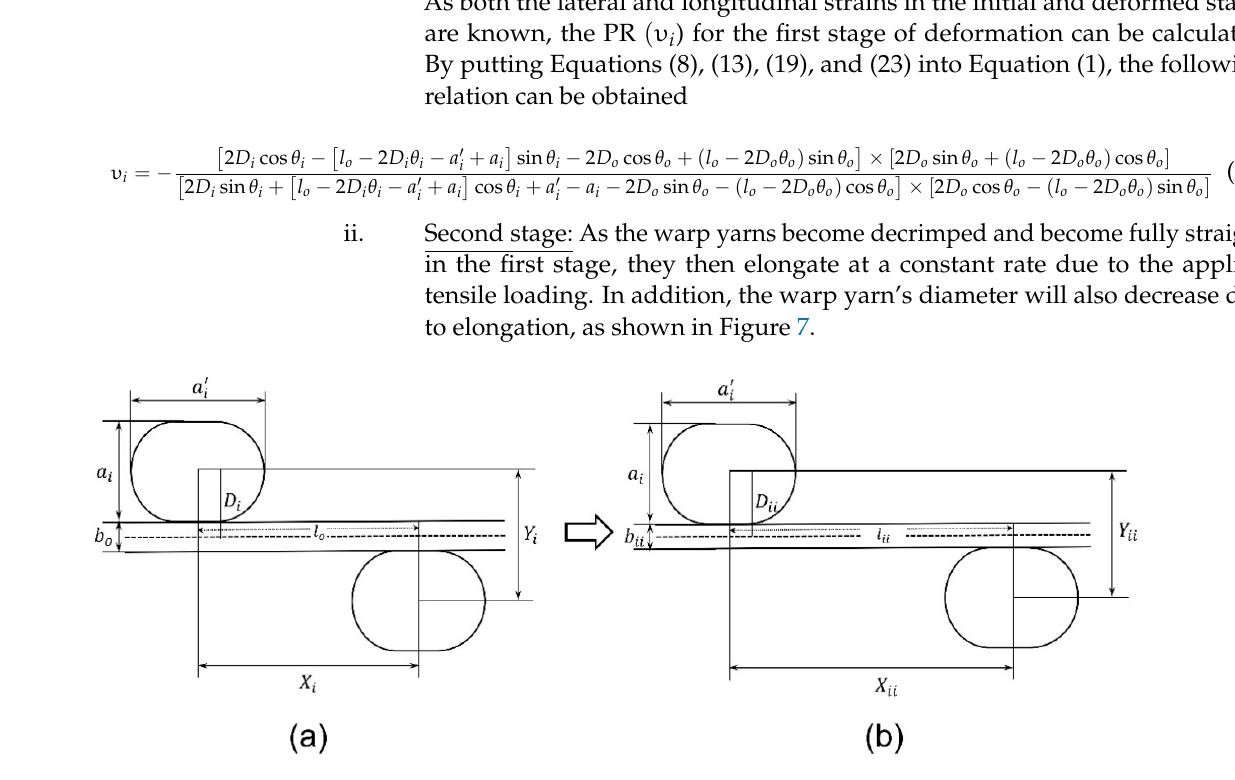
Figure 7. Second stage of deformation of a unit cell: ( a ) decrimped and ( b ) elongation of warp